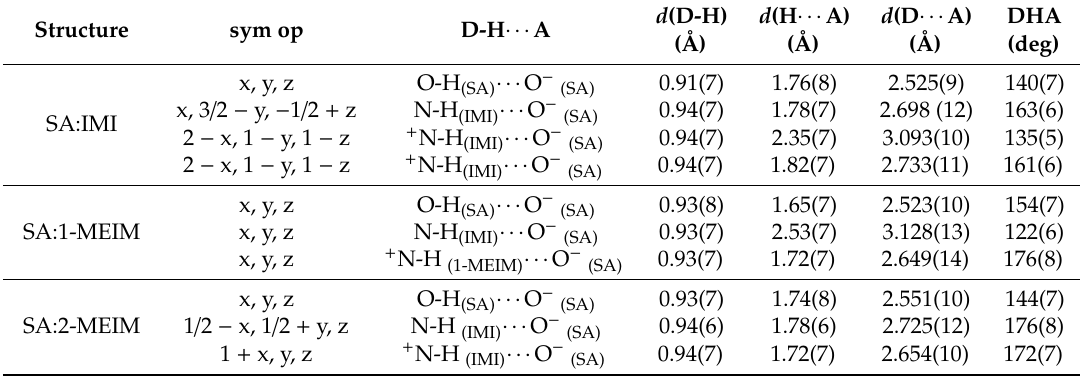
Table 2. Hydrogen-bond distances and angles for the reported crystal